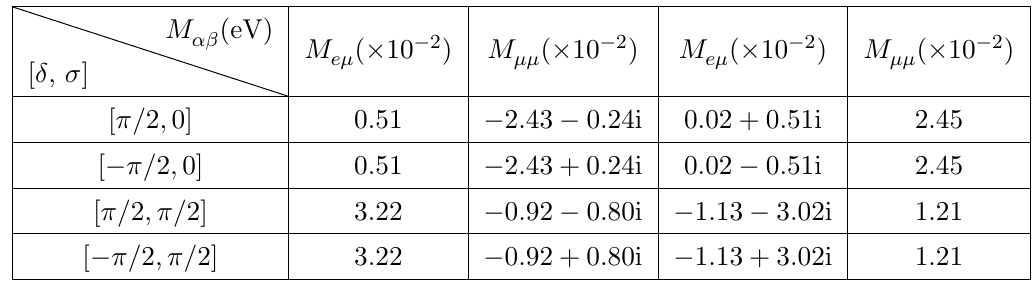
and M for various combinations of (cid:14) and (cid:27) in the IH case, e(cid:22) (cid:22)(cid:22)